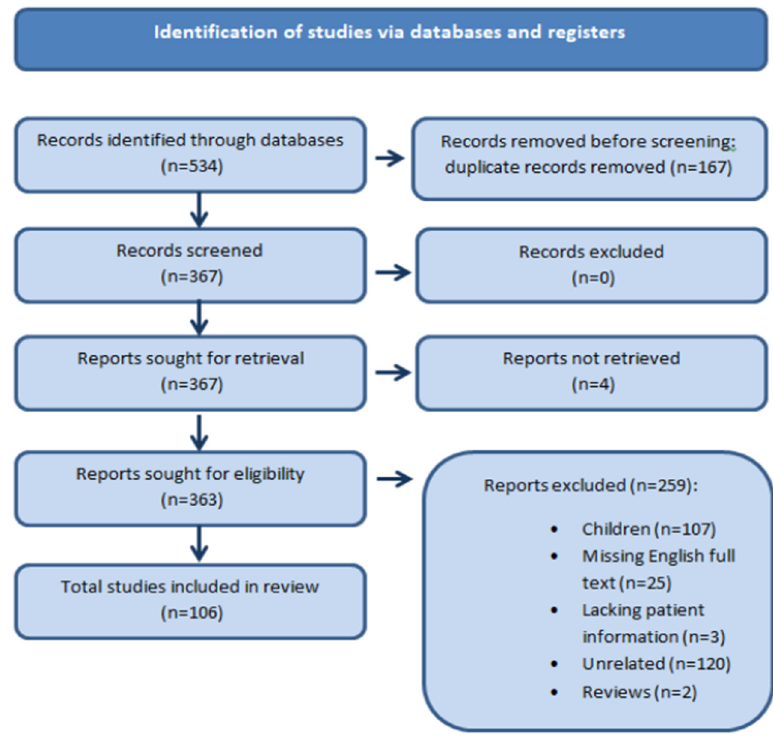
Figure 1. PRISMA flow diagram of the search for PPT.